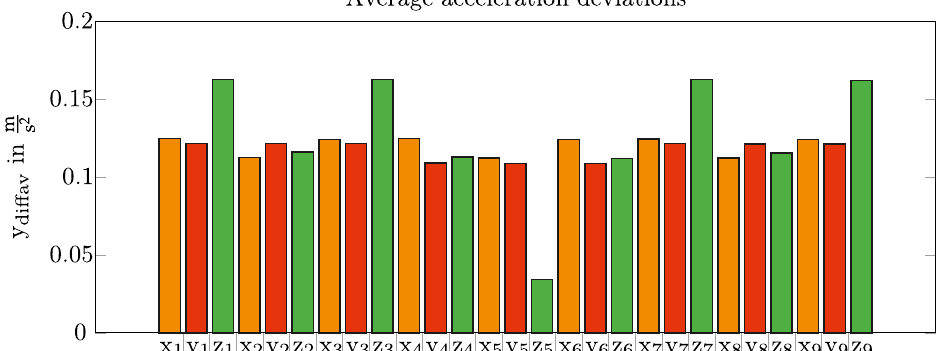
Figure 7. Over all platforms averaged acceleration deviations calculated from the difference of platform arrangements with faulty ropes and faultless